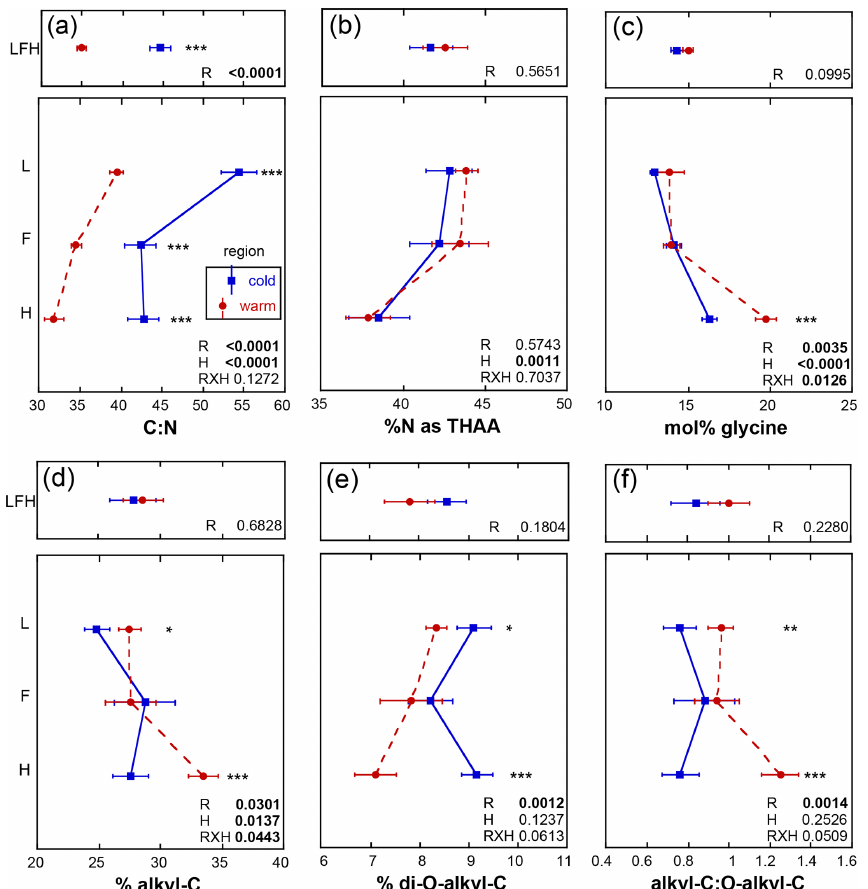
Figure 3. Initial mean values ± standard error for soil metrics from each of the three sites given as the whole organic profile (LFH; upper panels) and individual horizons ( L , F , H ) from the isolated experiment (lower panels). An analysis of variance was used to assess the effect of region ( R ) within the organic profile, and the effect of R , horizon ( H ), and their interaction within the individual horizons in which the significance of the effect of R within the horizon is denoted with the following asterisks: ∗∗∗ p ≤ 0 . 0001, ∗∗ p ≤ 0 . 001, ∗ p ≤ 0 . 05, and n.s. (not significant): p> 0 .